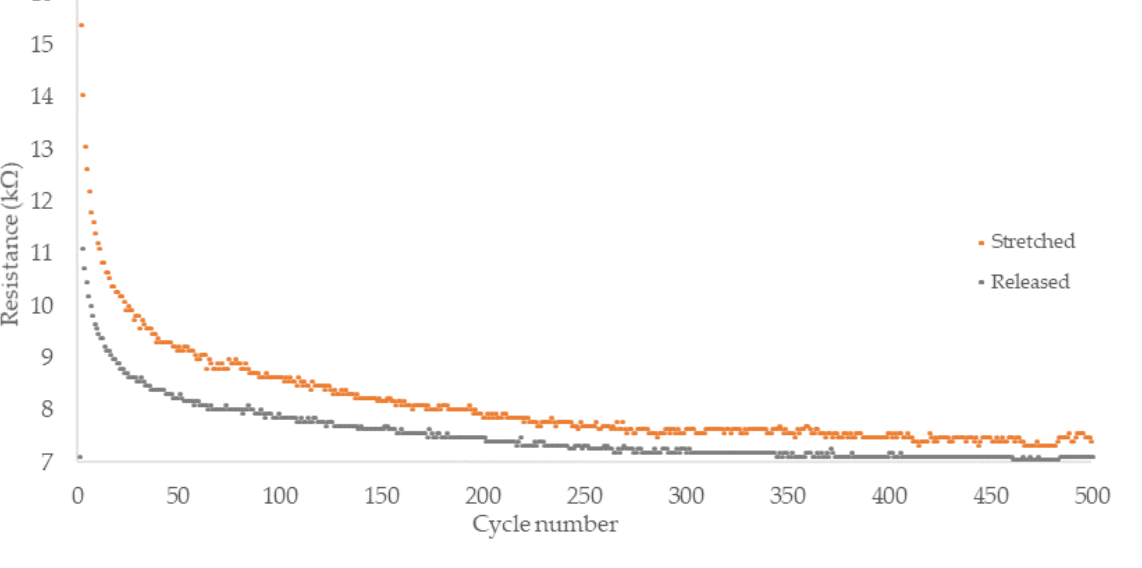
Figure 6. Cyclic strain testing of FM1 composite fiber. Strains of 20% were carried out by 2 s of stretching followed by immediate 2 s of releasing.